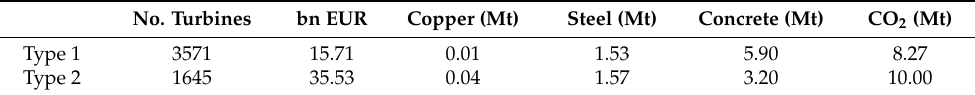
Table A2. Demand for the energy transition in terms of onshore/offshore turbines. No. Turbines